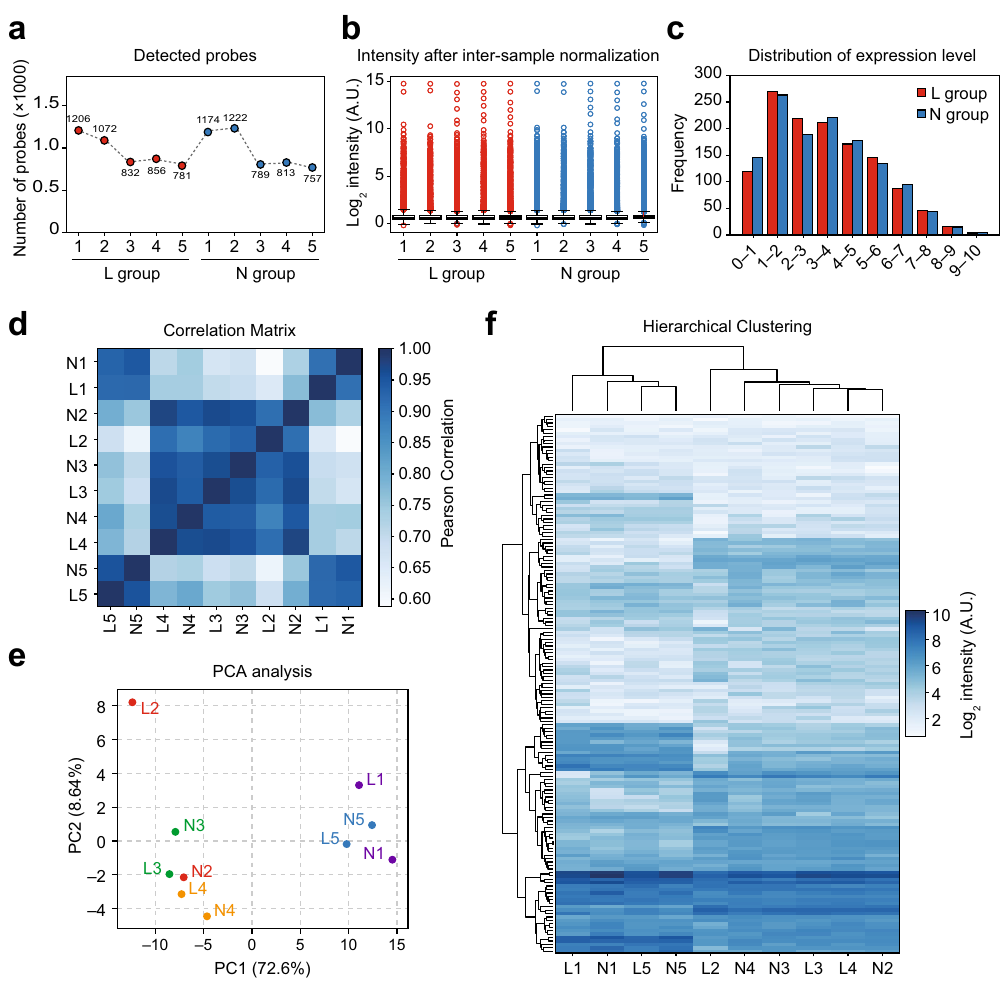
Figure 1. Quality evaluation of the miRNA microarray data. ( a ) Number of miRNA probes detected in each sample group. ( b ) Density plot showing the signal distribution of each sample group. ( c ) Box plot of the percentile values for the normalized expression levels of each sample group. ( d ) Correlation matrix for the degree of similarity, ( e ) principal component analysis (PCA), and ( f ) hierarchical clustering among the sample